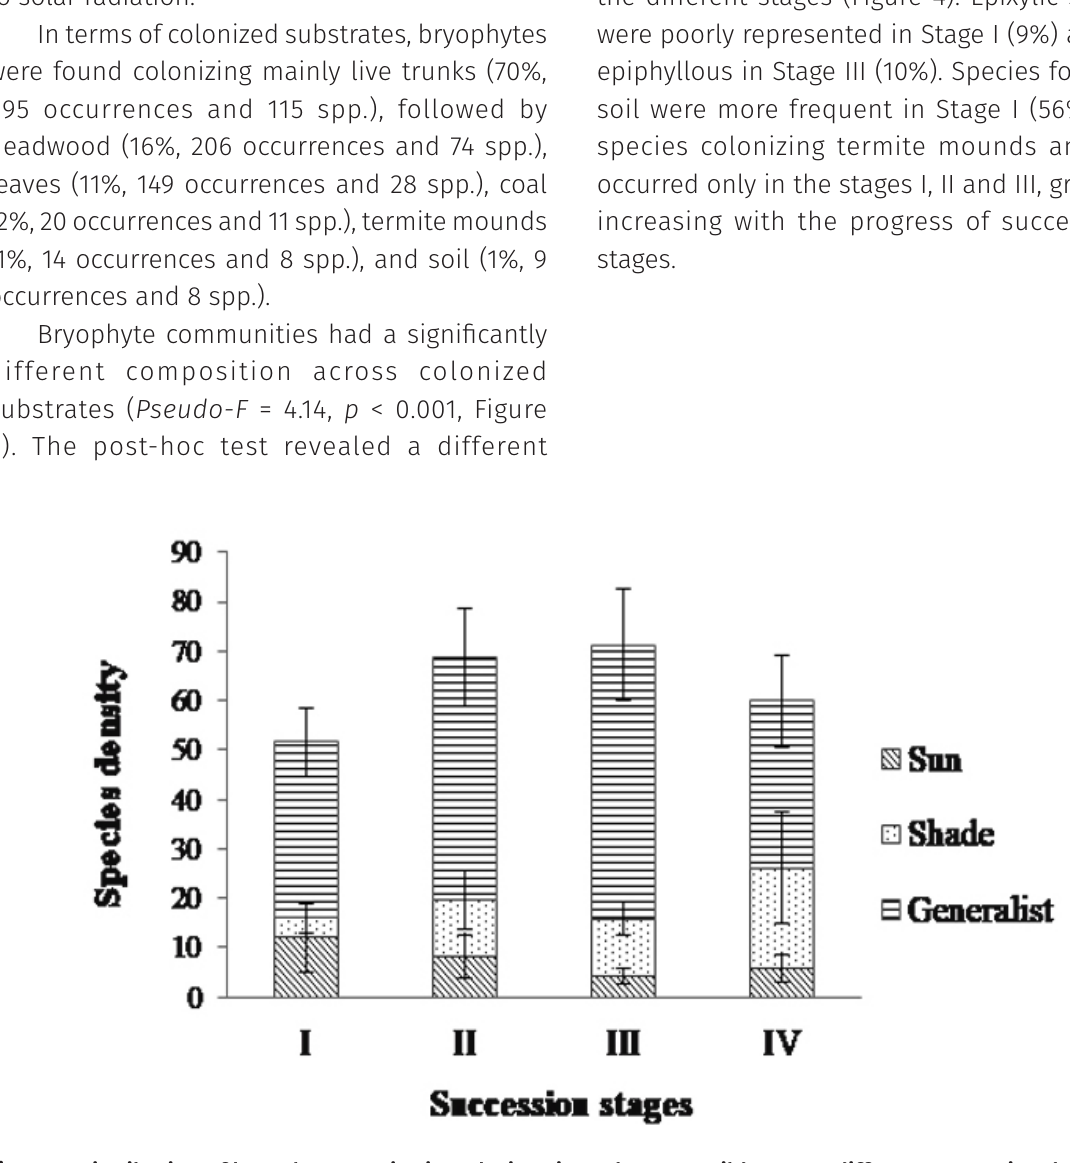
Figure 2. Distribution of bryophyte species into desiccation tolerance guilds across different successional stages in the Caxiuanã FLONA, Pará,